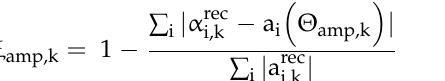
Figure 11. Example of APS contribution in the interferometric phase. Element ( a ) shows the interferogram before APS estimation, while ( b ) shows the same interferogram after APS estimation and element ( c ) shows the calculated atmosphere. B n refers to the normal baseline and h amb refers to height of ambiguity (example of VV-descending data). A standard evaluation of the atmosphere is the nonappearance of big “phase jumps” that indicates the good quality of the APS estimation.